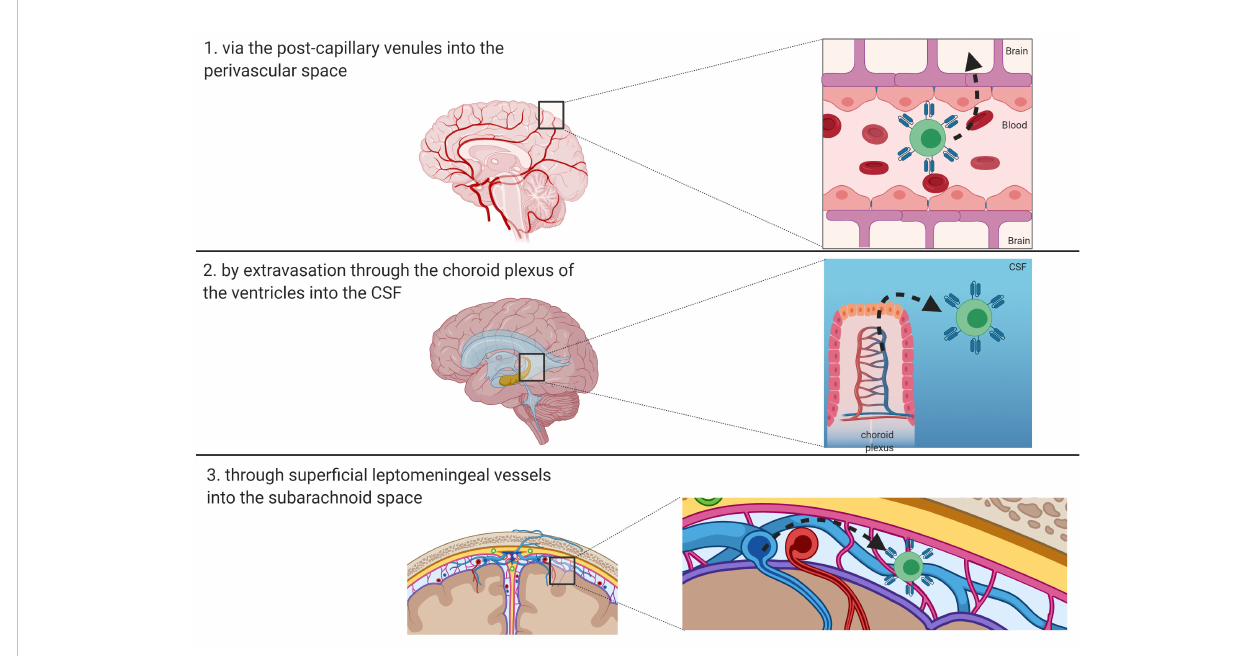
FIGURE 2 Route of entry of T-cells and CAR-T cells in the brain. Three main routes have been described and are depicted: 1) via the post-capillary venules into the perivascular space; 2) by extravasation through the choroid plexus of the ventricles into the CSF; or 3) through super fi cial leptomeningeal vessels into the subarachnoid